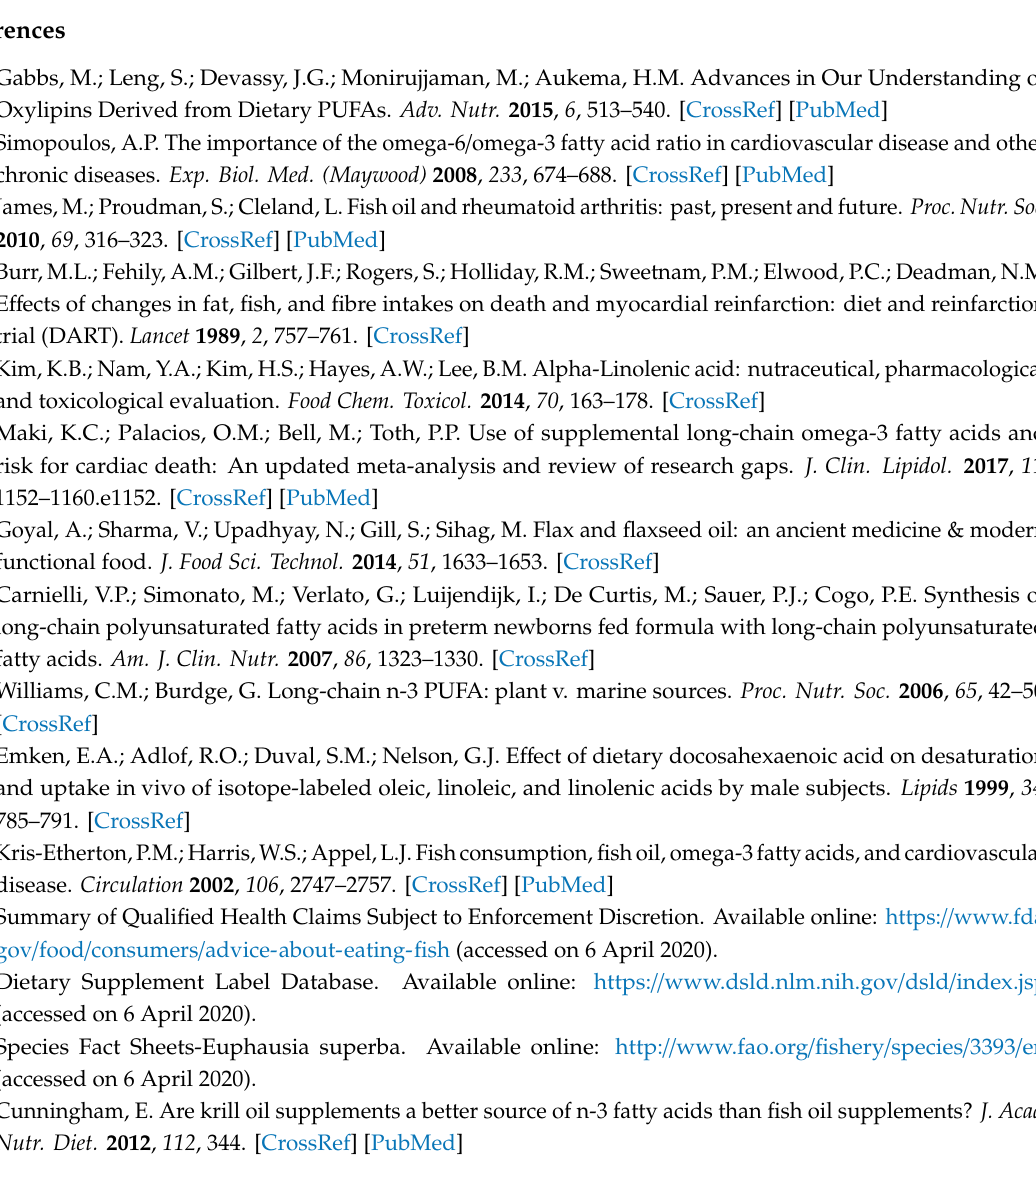
Table S1: Harmful substance contents of regulated values and the experimental oils, Table S2: Growth parameters of mice administered scallop oil for 28 days, Table S3: Organ weights of mice administered scallop oil for 28 days, Table S4: Liver thiobarbituric acid reactive substances (TBARS) and α -tocopherol ( α -Toc) levels in